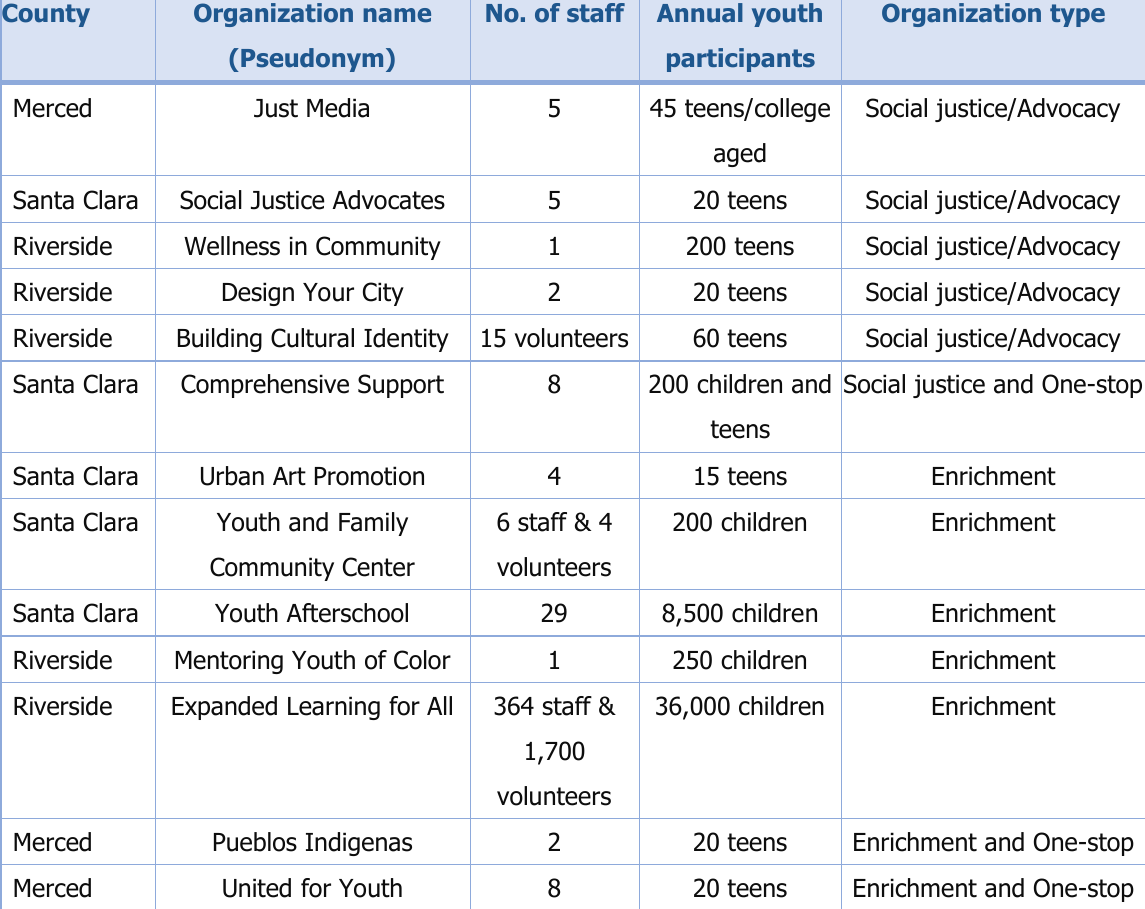
Table 2. Organization Location, Type, and Staffing and Participant